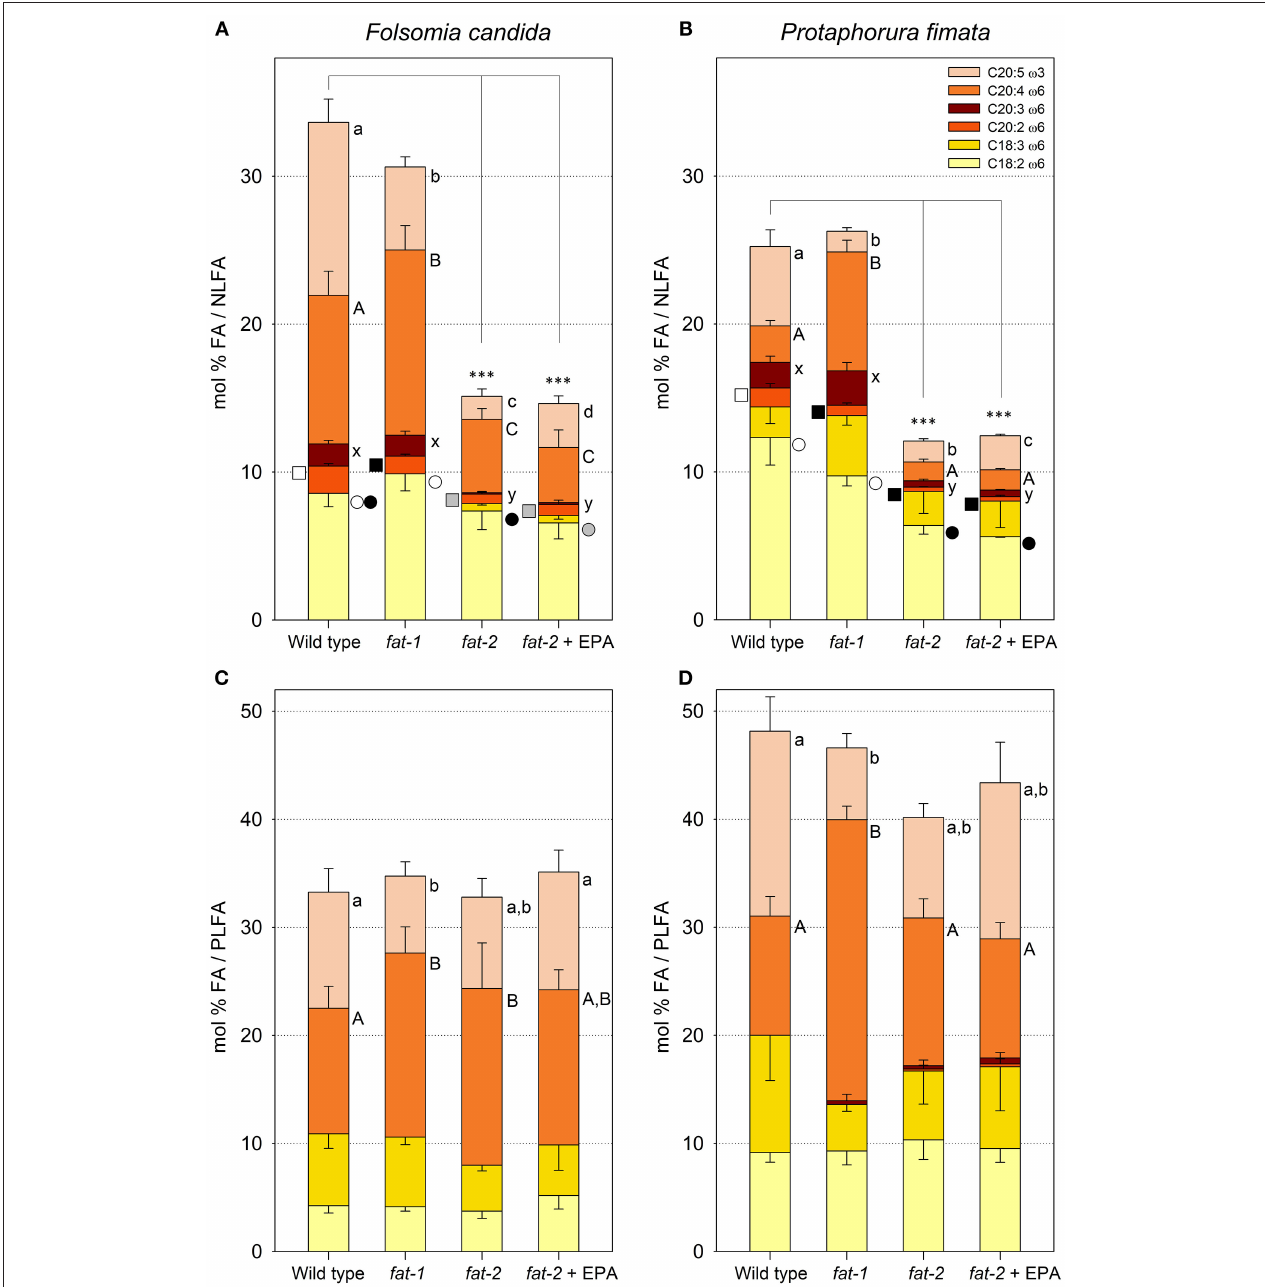
FIGURE 2 | Profiles of polyunsaturated fatty acids (PUFA) in the Collembola species Folsomia candida and Protaphorura fimata , as mol % relative to the total fatty acid content of the neutral lipid (NLFA) and phospholipid (PLFA) fatty acid fractions. (A) NLFA of F. candida , (B) NLFA of P. fimata , (C) PLFA of F. candida, and (D) PLFA of P. fimata . Statistical differences were tested for each PUFA within each experimental set and Bonferroni post-hoc test results are represented by letters and full or empty symbols. Matching (or missing) letters and symbols indicate no statistical difference. Stars indicate a significantly lower proportion of total PUFA on the NLFA, when compared to the corresponding wild type sample. All corresponding F - and P -values are given in Supplementary Table 6, together with means and standard deviations.